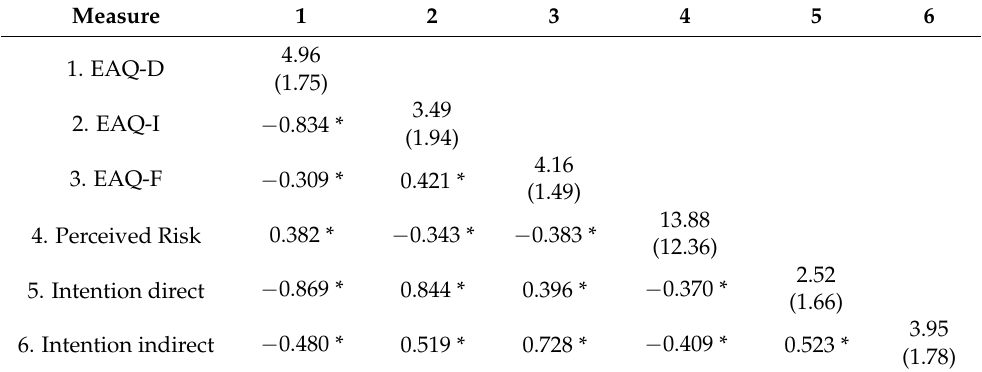
Table 3. Summary of the study variables intercorrelations, means and standard deviations ( n = 194).